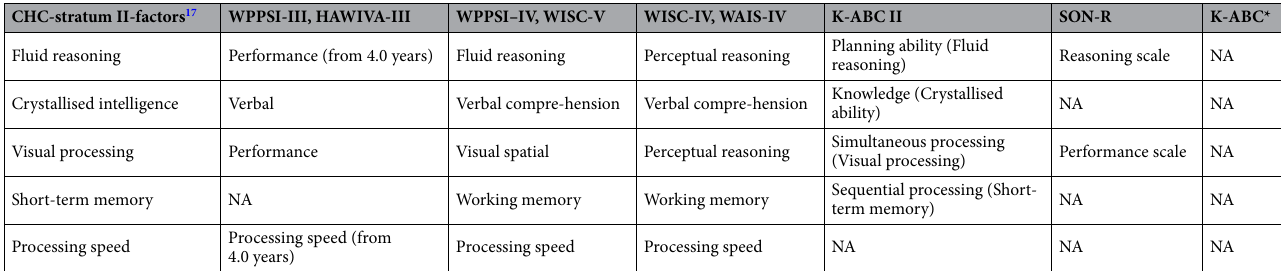
Table 1. Attribution of IQ test subscales to cognitive functions (according to Cattell-Horn-Carroll [CHC] theory) 17 . CHC Cattell-Horn-Carroll, HAWIVA Hannover-Wechsler-Intelligenztest für das Vorschulalter, K-ABC Kaufmann Assessment Battery for Children, NA not applicable, SON-R Snijders-Oomen Nonverbal Intelligence Test Revised, WAIS Wechsler Adult Intelligence Scale, WISC Wechsler Intelligence Scale for Children, WPPSI Wechsler Preschool and Primary Scale of Intelligence. *Attribution was not